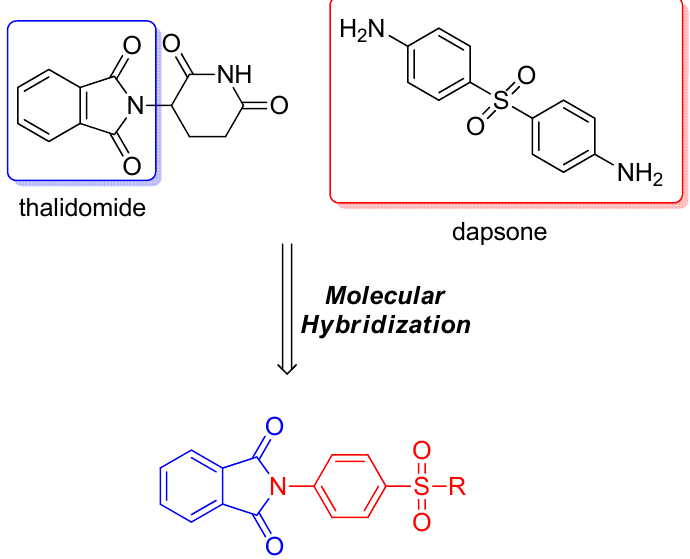
Figure 6. Hybrid of thalidomide anti-inflammatory moiety and dapsone effective against Mycobacterium tuberculosis , with anti-inflammatory and analgesic